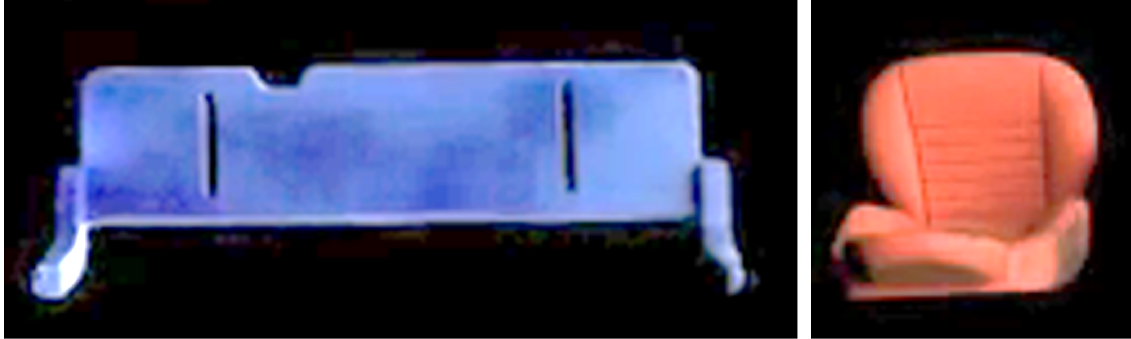
Sensors 2022 , 22 , x FOR PEER REVIEW Figure 10. Typical data samples were collected from prediction videos. Figure 10. Typical data samples were collected from prediction videos.